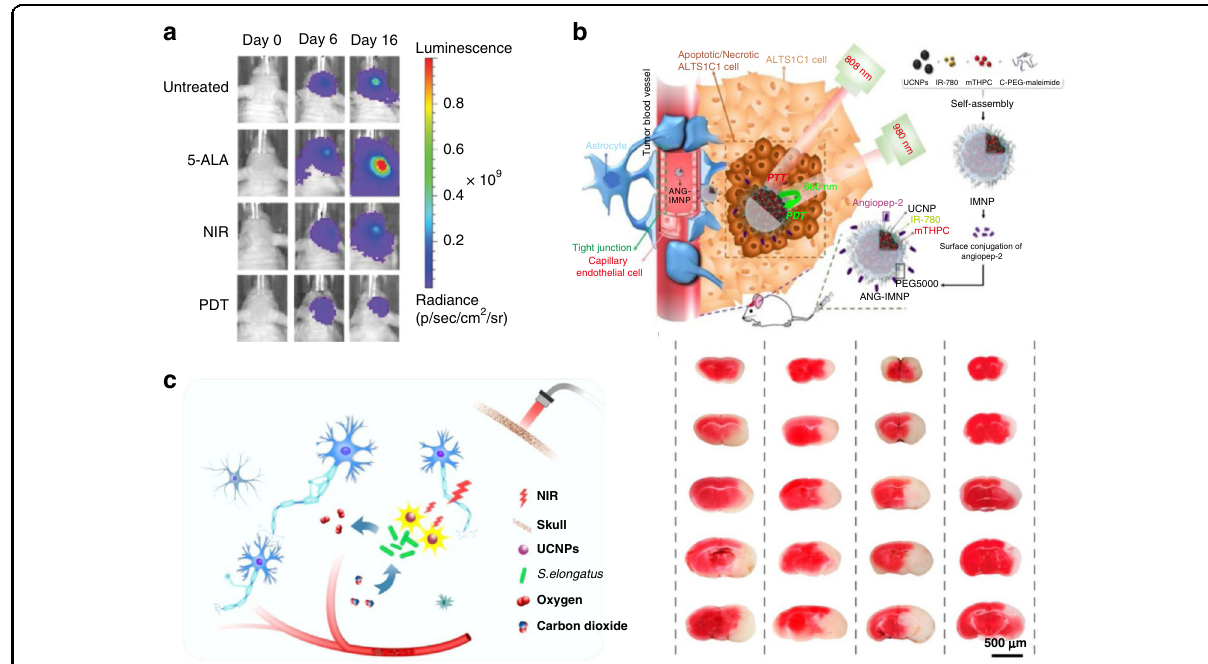
Fig. 6 Rare-earth based materials for brain disease therapy. a PDT therapy of brain glioblastoma. Reprinted with permission from ref. 18